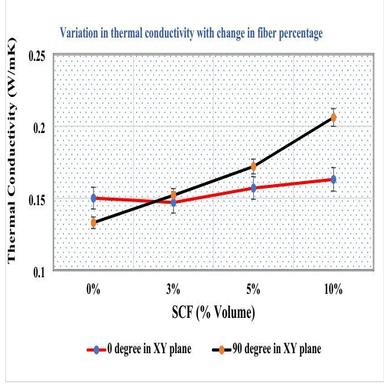
Variation in thermal conductivity of the SCF/PC composite with change in fiber content.